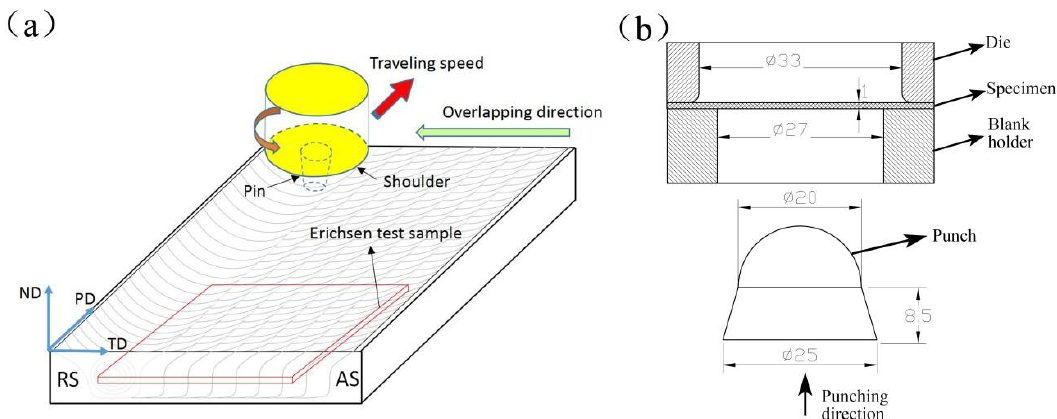
Figure 1. ( a ) Schematic illustration of multi-pass friction stir processing (M-FSP) plate showing the machining position of Erichsen cupping test samples; ( b ) experimental set-up of the stamping die.